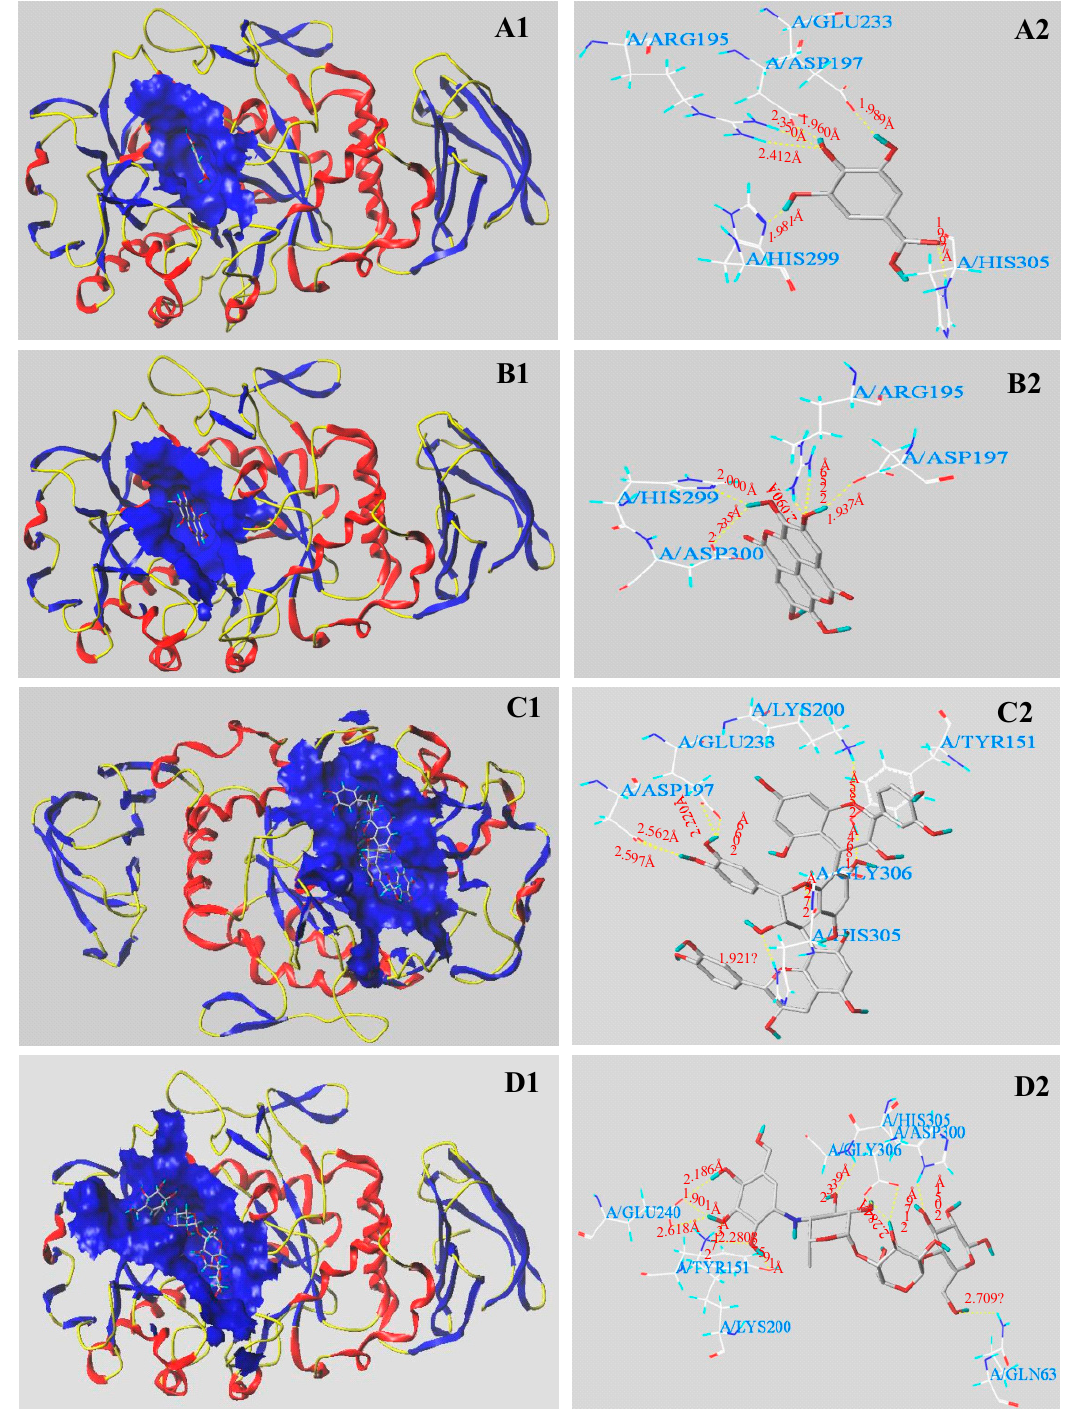
Figure 6. Molecular docking of the main three phenolic compounds and acarbose with α -amylase. The 3D docking structures of three phenolic compounds and acarbose were inserted into the hydrophobic cavity of α -amylase (blue): gallic acid ( A1 ); ellagic acid ( B1 ); procyanidin C3 ( C1 ); acarbose ( D1 ). The conformations of active molecules interactions with amino acid residues in the active site of α -amylase: gallic acid ( A2 ), ellagic acid ( B2 ), procyanidin C3 ( C2 ), and acarbose ( D2 ) with residues in the active sites of the α -amylase, respectively. The dashed line stands for hydrogen bonds.